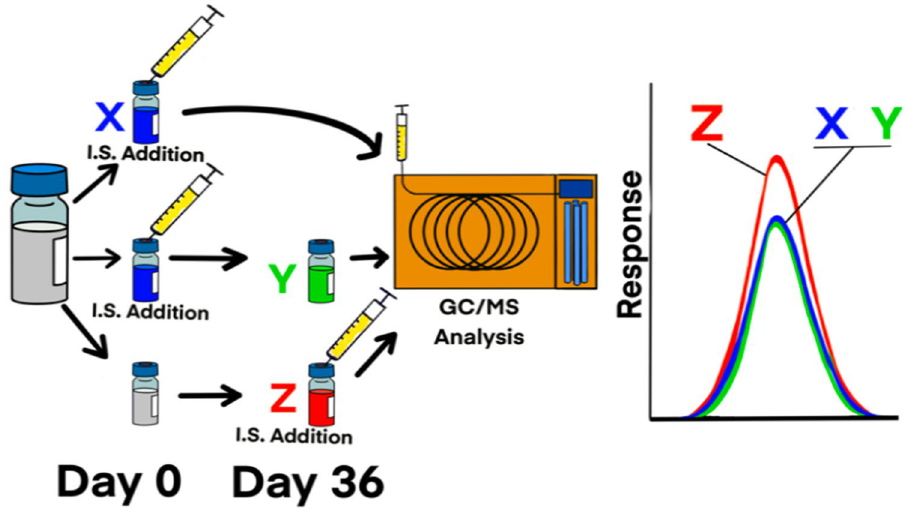
Figure 2. A schematic showing that steps X and Y (Fig. 1) led to identical results, but that step Z , led to higher SVOC concentration readings.